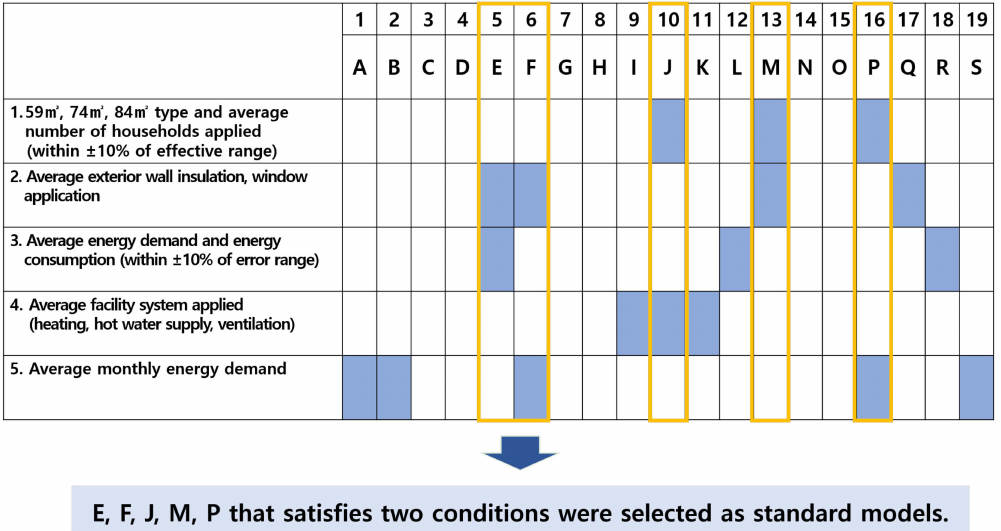
Figure 6. The frequency analysis results showing occurrence of two or more of the five types of 1. TYPE, 2. exterior wall insulation, 3. windows, 4. ventilation, 5. energy demand and consumption, out of 46 MDU